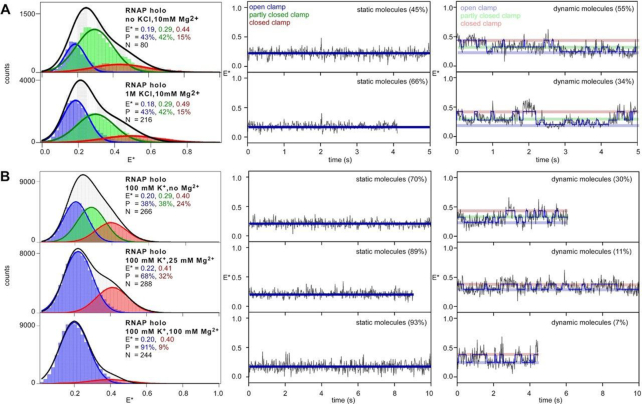
Modulation of RNAP clamp conformation by different concentrations of a monovalent and a divalent salt. (A) smFRET data monitoring clamp conformation in presence of no K+ (top) or 1000 mM K+ concentration (bottom). (left subpanels) histograms and Gaussian fits of HMM-derived E* distributions for all molecules, showing open (blue), partly closed (green) and closed (red) clamp states; P, subpopulation percentage; N, number of molecules; black line, sum of gaussian fits to the three states; (middle subpanels) representative time trace of E*, showing a molecule in a static open clamp state (right subpanels) representative time trace of E*, for a dynamic molecule showing HMM-assigned states, and interstate transitions (blue line). (B) smFRET data monitoring clamp conformation in presence of increasing Mg2+ concentrations (no Mg2+, 25 mM Mg2+ and 100 mM Mg2+). (left subpanels) histograms and Gaussian fits of HMM-derived E* distributions for all molecules; Colors and symbols as in A; (middle subpanels) representative time traces of E*, showing molecules in a static open clamp state (right subpanels) representative time trace of E*, for a dynamic molecule showing hidden-Markov-model (HMM)-assigned states and interstate transitions (blue line). Relative percentages of the populations are inset. Frame rate was 20 ms and laser powers were 3.5 mW in green and 0.75 mW in red.